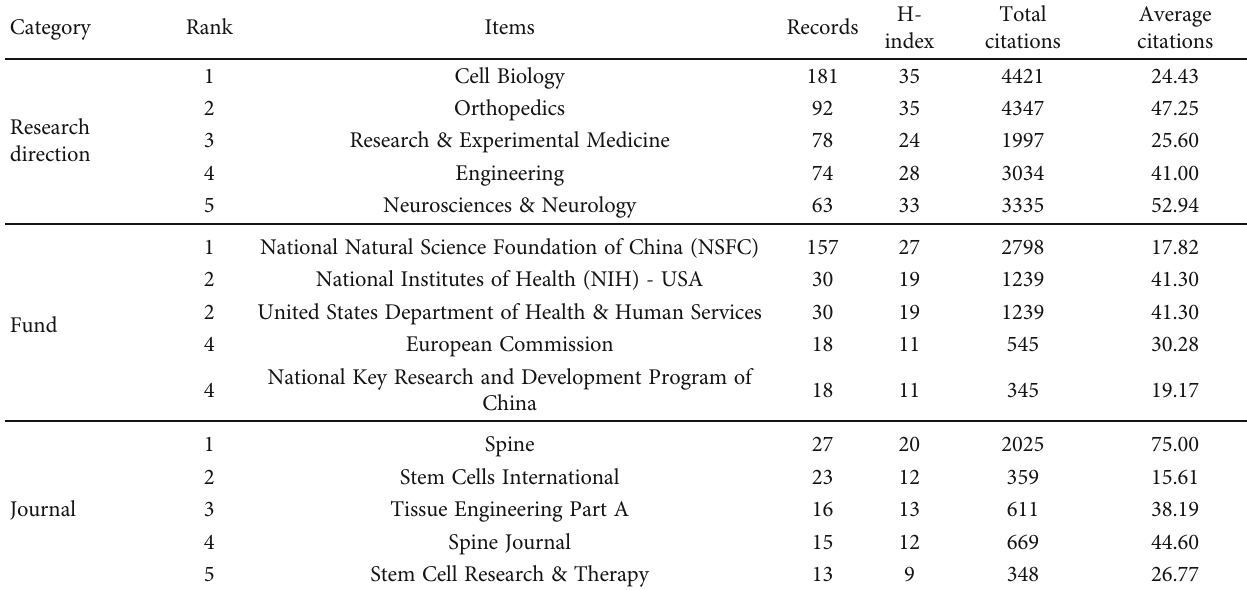
Table 3: The top 5 high-yield research directions, funds, and journals with the most publications on stem and progenitor cells in intervertebral